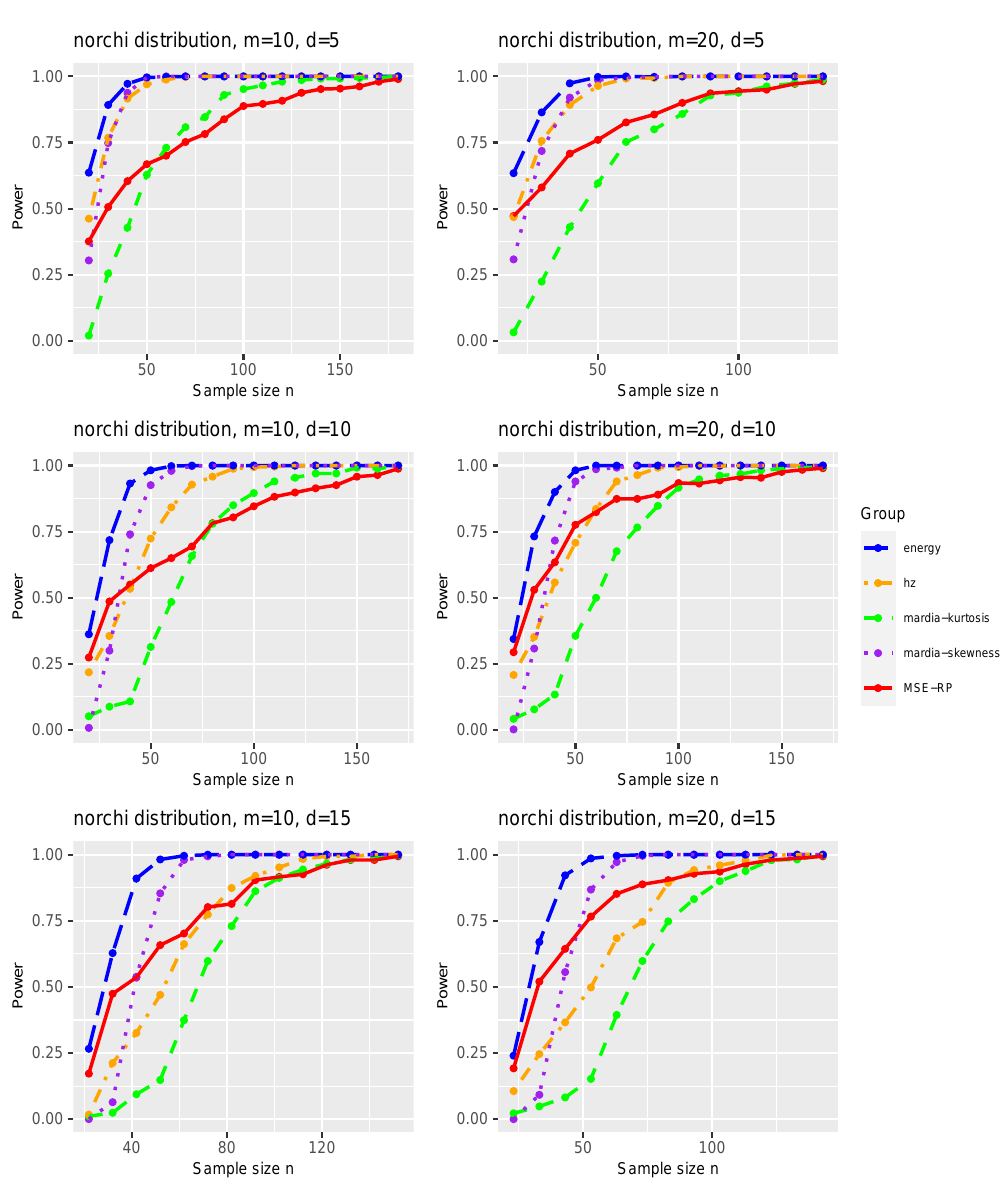
Figure A1. Power ( α = 0.05) comparison for N ( 0,1 ) + χ 2 ( 2 )